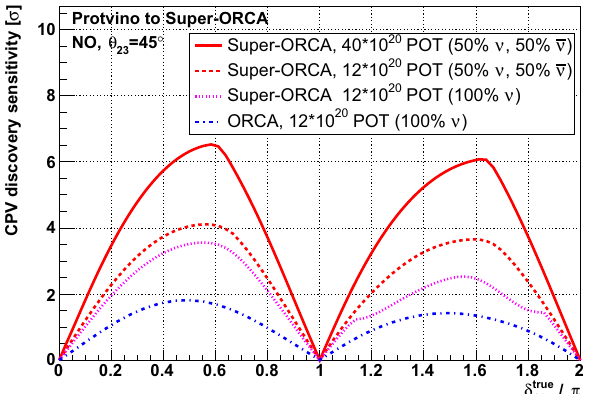
Fig. 14 Sensitivity to detect CP violation by operating ORCA 3 years (100% ν beam, shown by dash-dotted line), Super-ORCA 3 years (dot- ted line for 100% ν beam and dashed line for 50% ν/ 50% ¯ ν beam) and Super-ORCA 10 years (solid line for 50% ν/ 50% ¯ ν beam) in a 450kW beam from Protvino. The sensitivity is shown as a function of the true δ δ = 0 and δ = π correspond to CP conservation) CP value ( CP CP